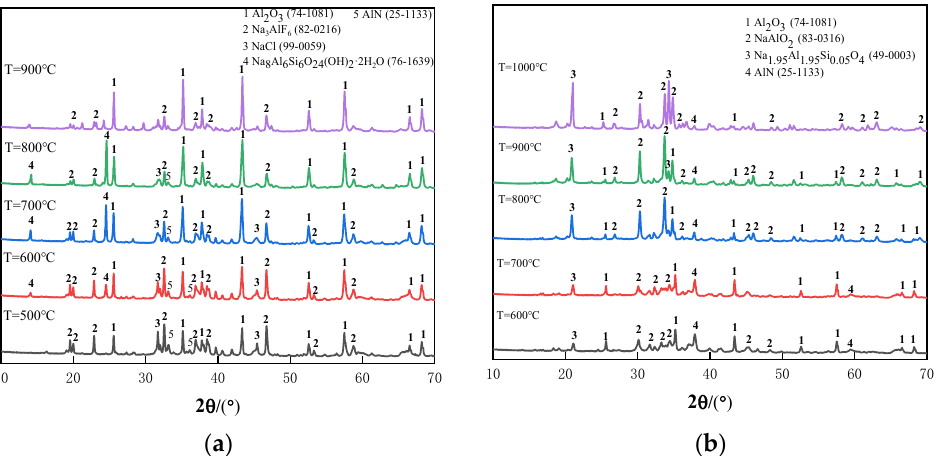
Figure 7. XRD patterns of different temperatures. ( a ) XRD pattern of the sample with cryolite; ( b ) XRD pattern of the sample with sodium carbonate.